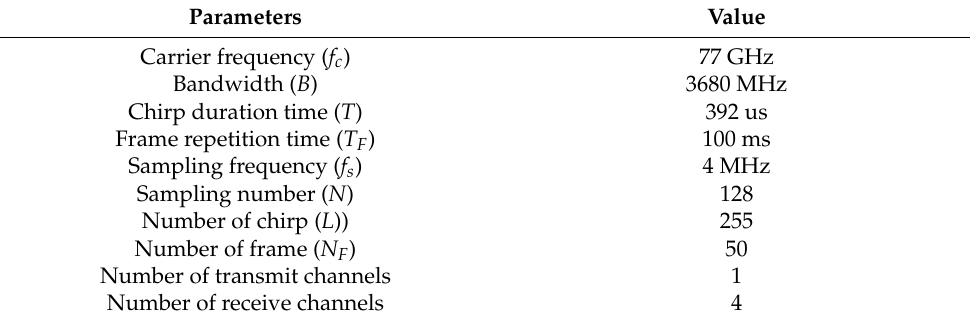
Figure 10. Experimental scenarios for collecting human activity data. Table 1. FMCW radar parameters.